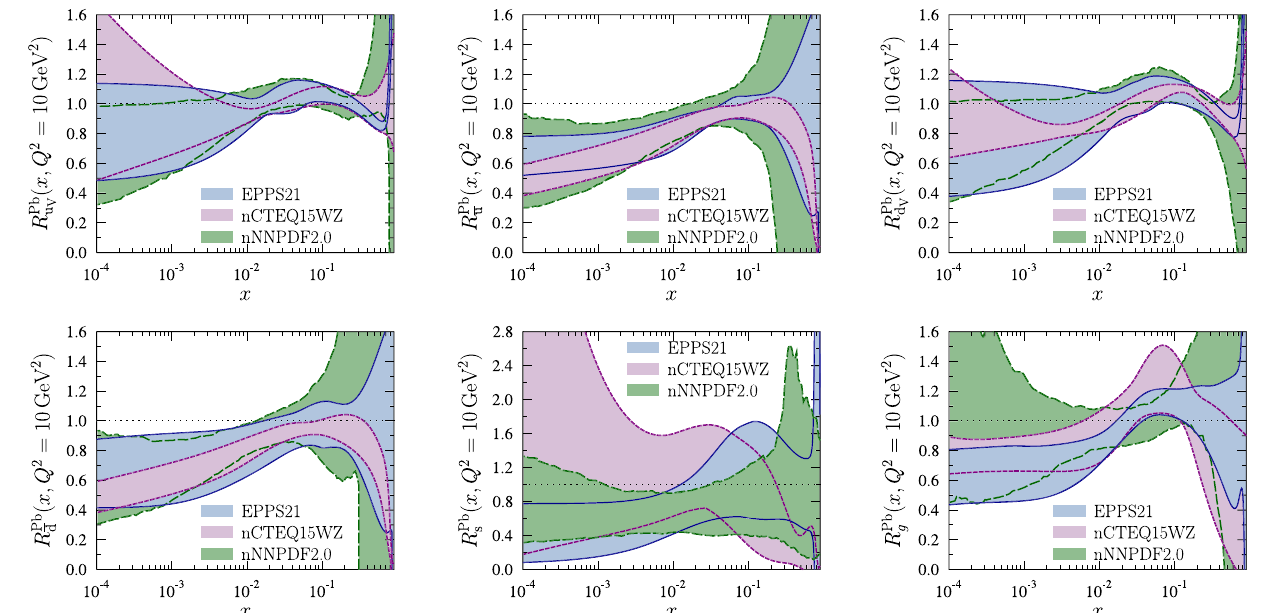
Fig. 9 Comparison between the EPPS21 (blue), nCTEQ15WZ (purple) [94], and nNNPDF2.0 (green) [10] average-nucleon nuclear modifications at Q 2 = 10GeV 2 . The EPPS21 and nNNPDF uncertainties include the free-proton uncertainties but the nCTEQ15WZ error bands only include the nuclear uncertainty